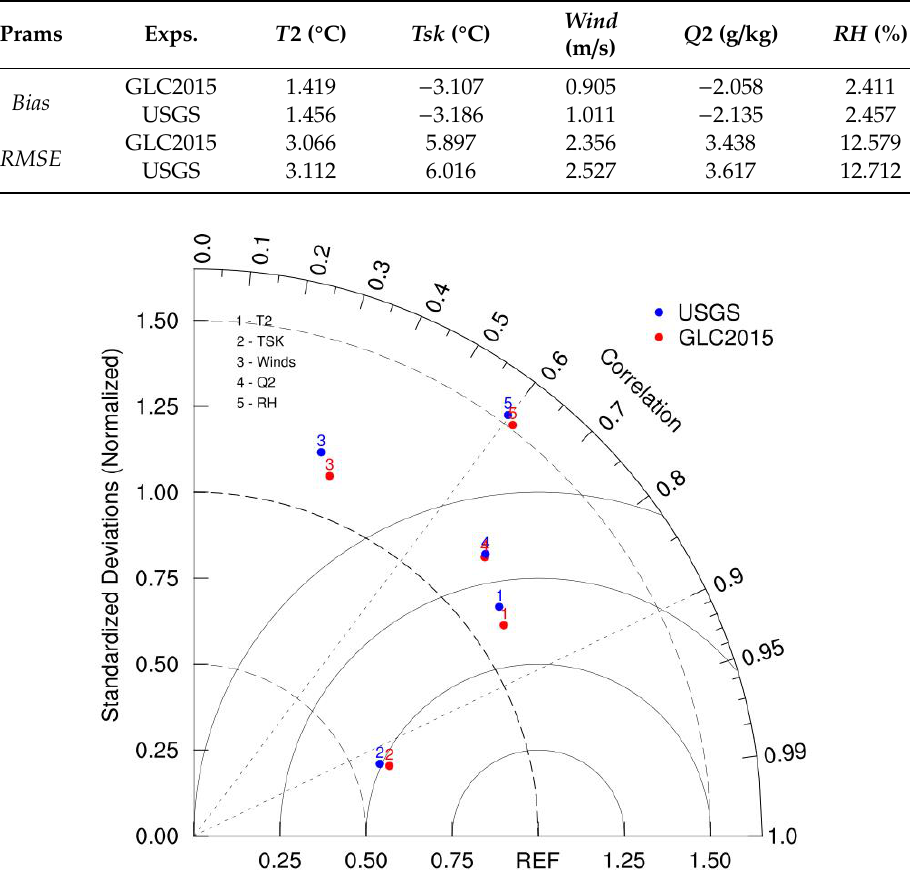
Table 3. Bias and RMSE of the air temperature, surface skin temperature, winds speed, specific humidity and relative humidity simulated by GLC2015 and USGS.